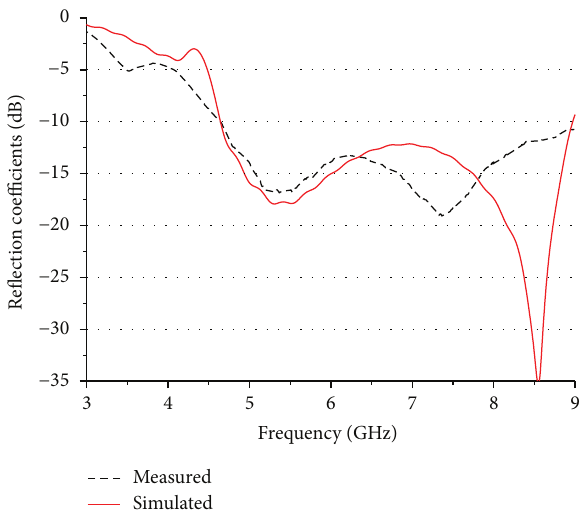
Figure 4: Simulated and measured results of reflection